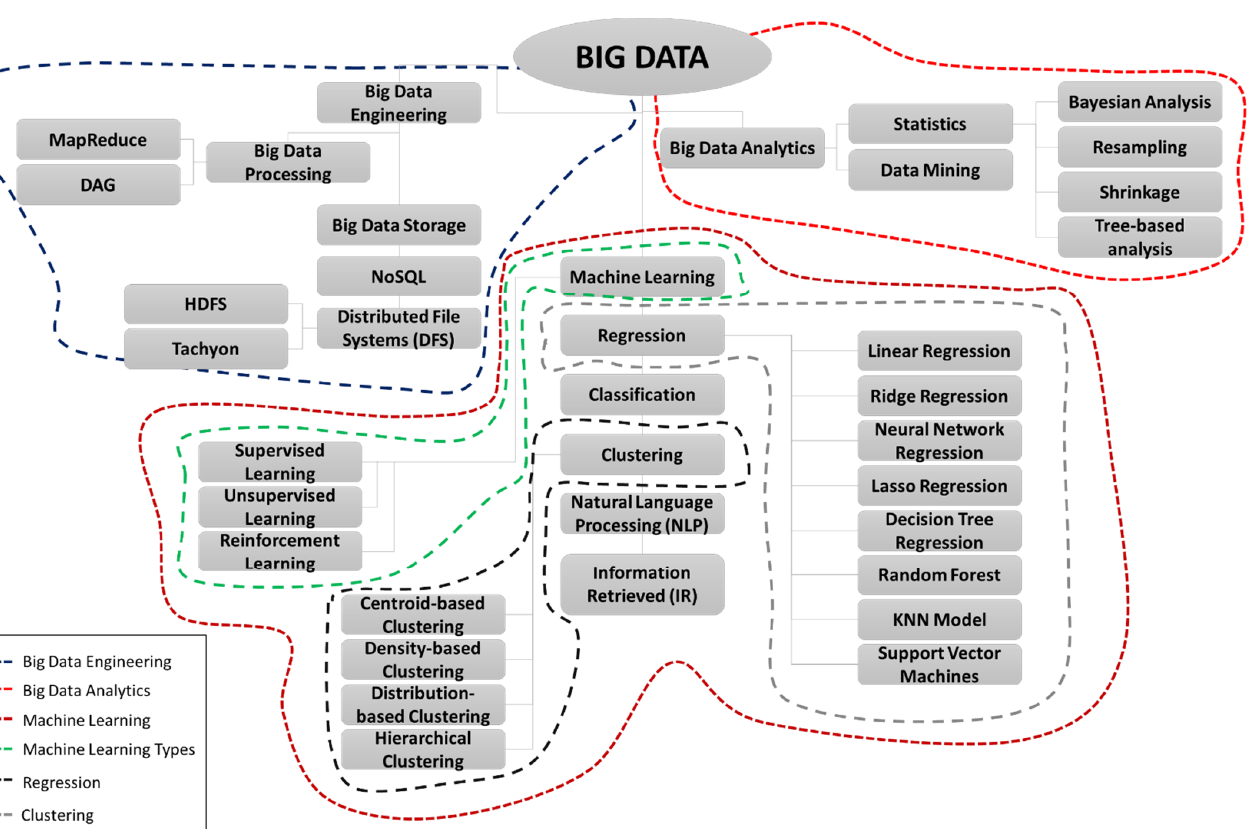
Figure 6. Classification of big data into its key domains.